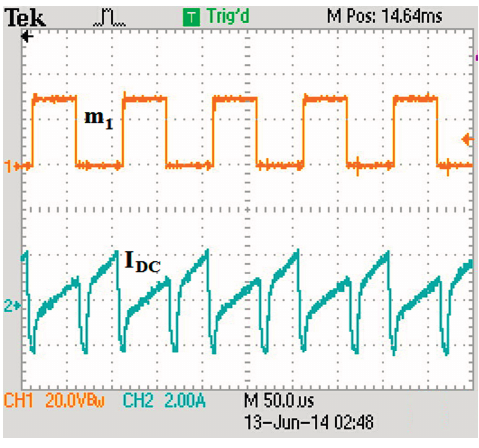
Figure 12. I DC and m 1